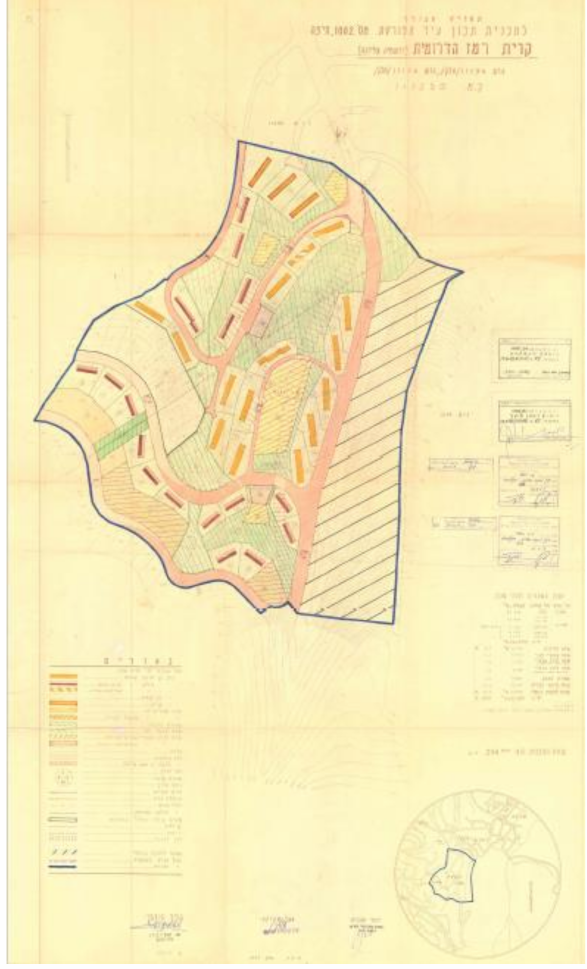
Figure 1. The 1957 project plan. According to the zeitgeist, it is not signed by an architect but by the Shikun Ovdim construction company. Source: the Israeli “Available Planning” website (The Planning Administration, Ministry of Interior)